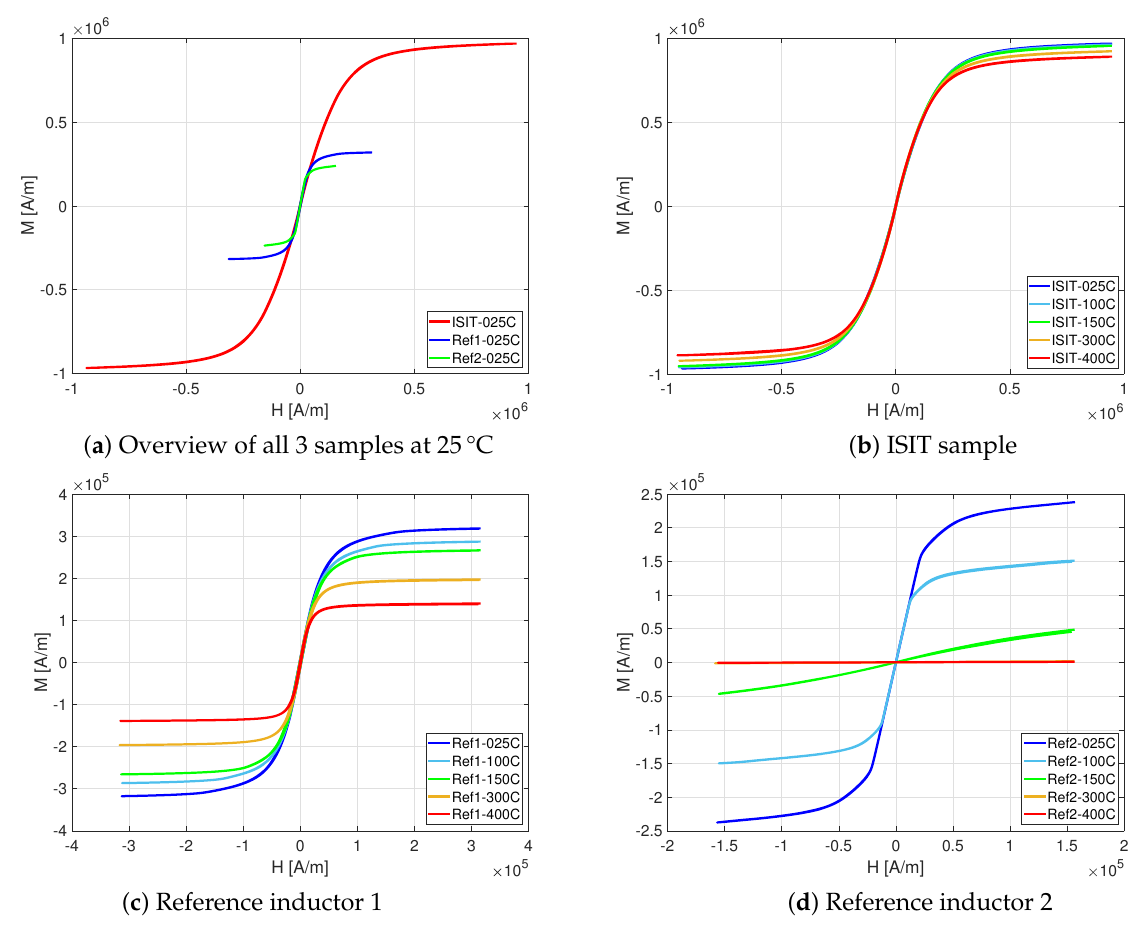
Figure 11. VSM temperature measurements.